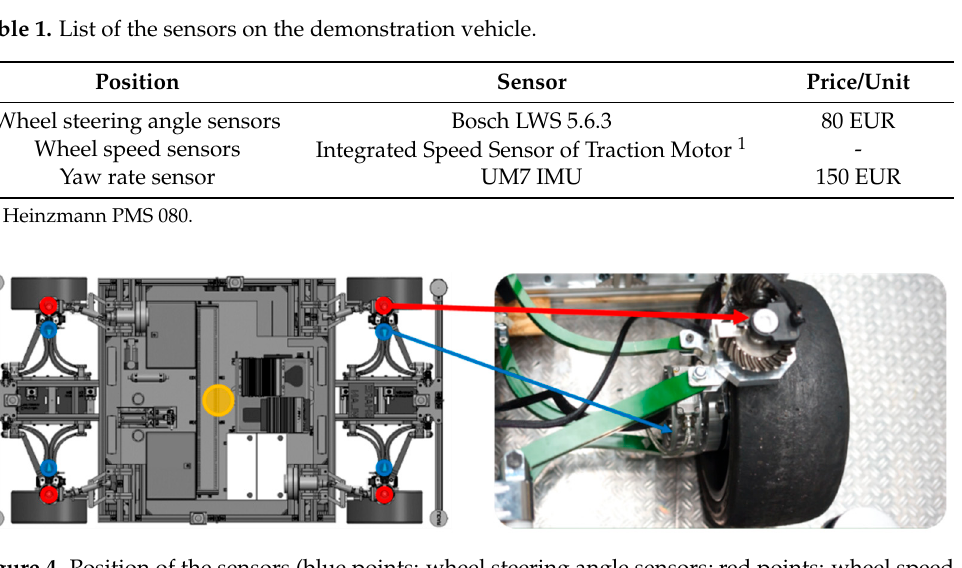
Figure 4. Position of the sensors (blue points: wheel steering angle sensors; red points: wheel speed sensors; yellow point: yaw rate sensor).